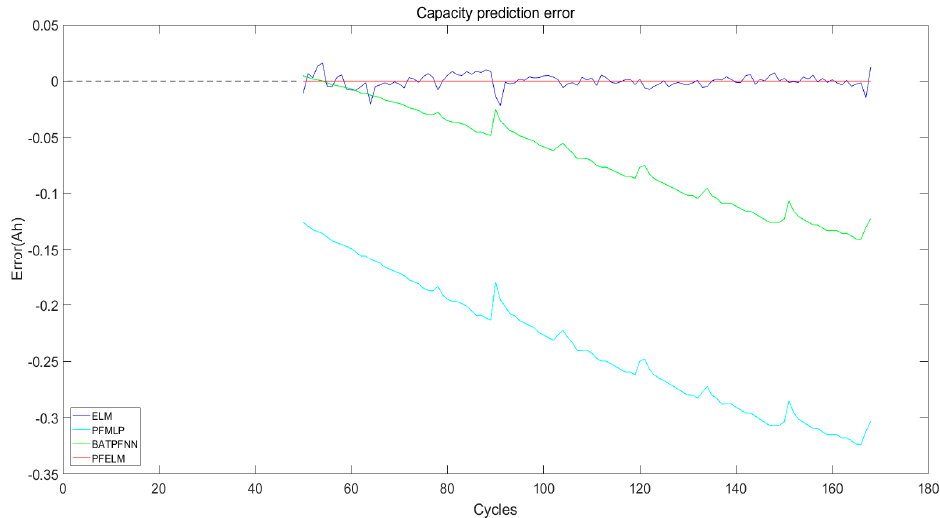
Figure 6. Predicting capacity from the 50th cycle by different algorithms: ( a ) ELM ; ( b ) PFMLP; ( c ) BATPFNN; ( d ) PFELM.